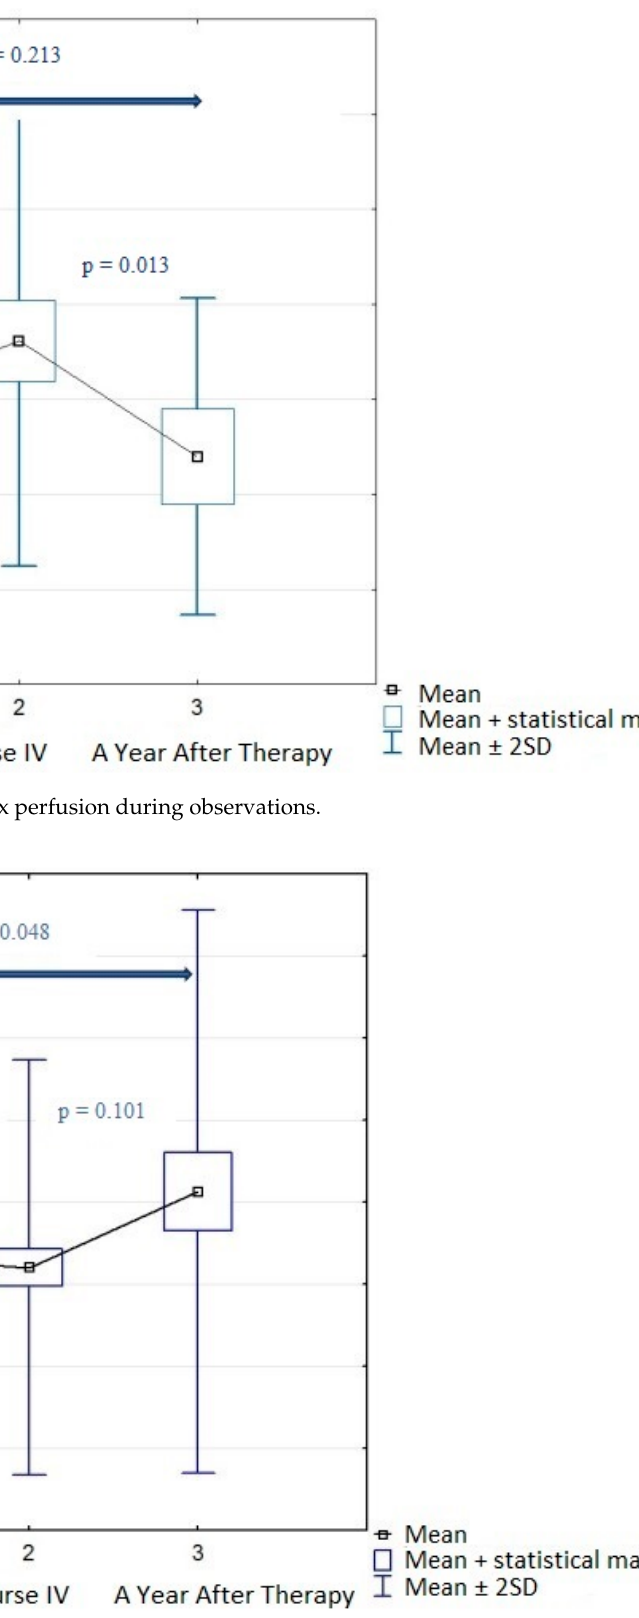
Figure 2. Diastolic blood pressure during observations.